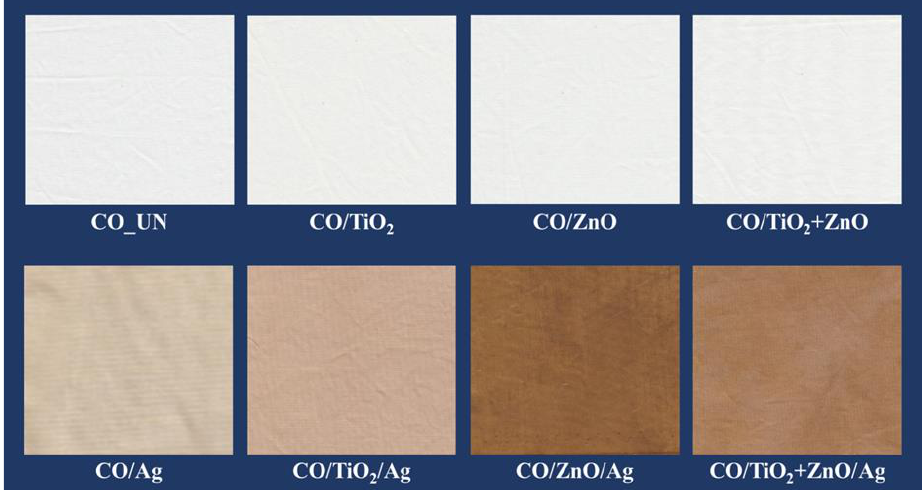
Figure 4. Photo images of untreated and chemically modified cotton samples.